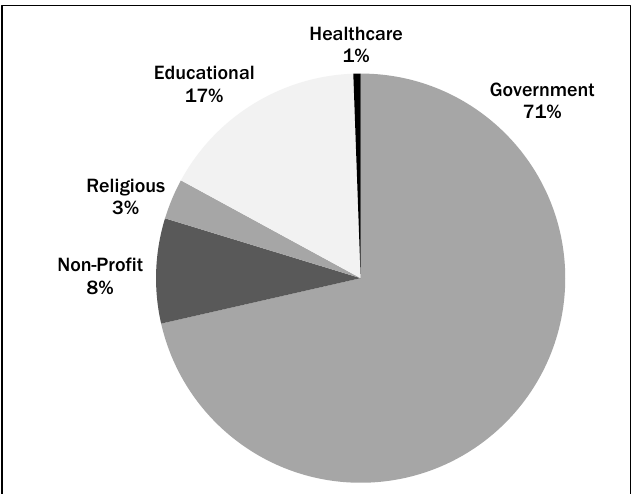
Figure 4. Ownership Category Percentages for Potential Agricultural Acreage, Based on Institutionally Owned Parcels after Site Suitability